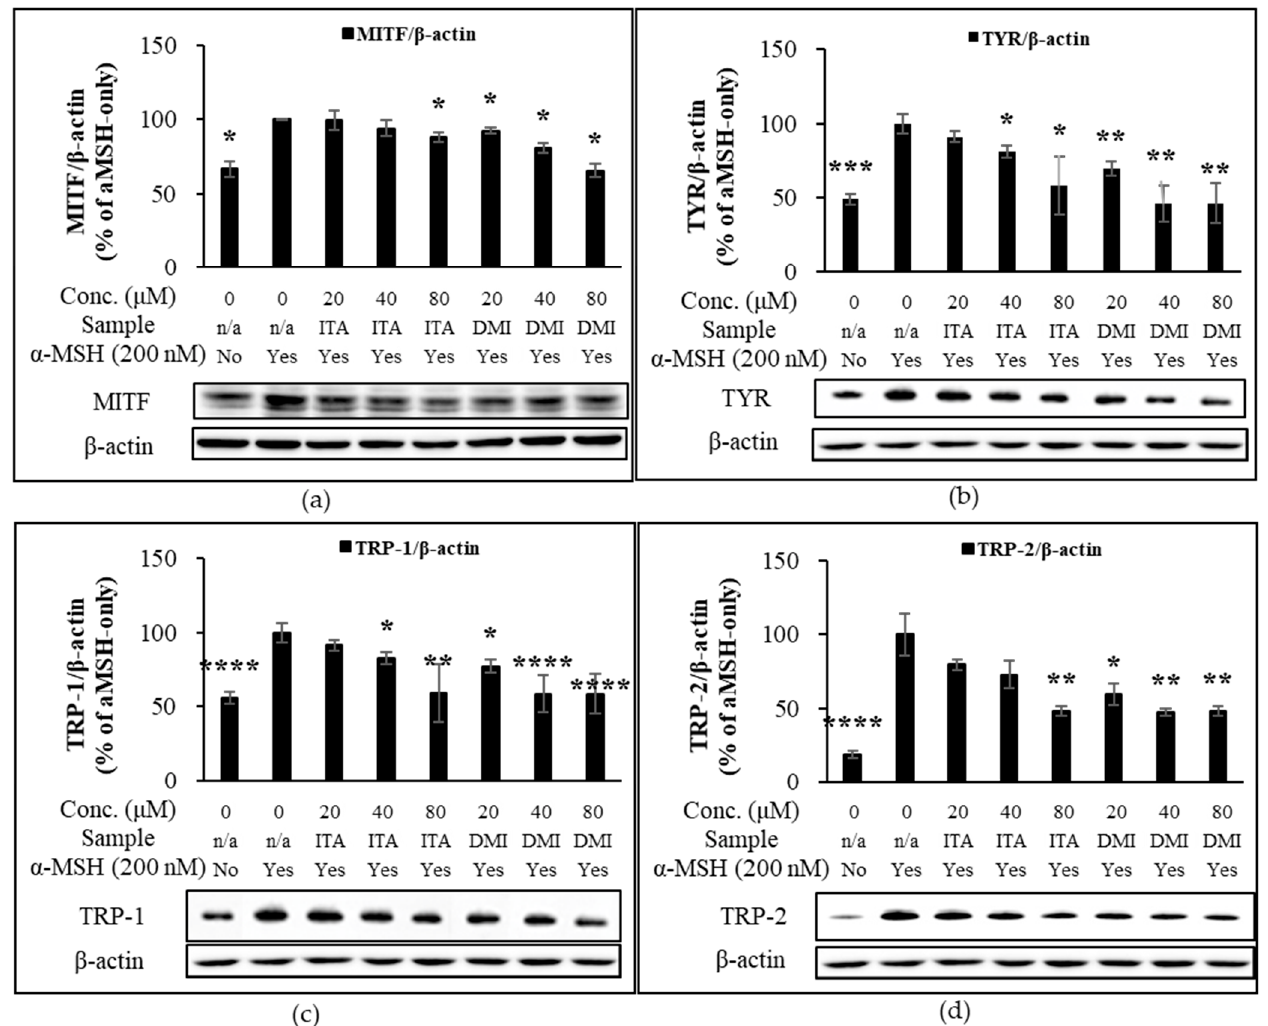
Figure 3. Effect of ITA and DMI on the α -MSH-induced expression of melanogenesis proteins. The expression level of melanogenic proteins was normalized to that of β -actin and compared to that of α -MSH only. ( a ) MITF/ β -actin. ( b ) TYR/ β -actin. ( c ) TRP-1/ β -actin. ( d ) TRP-2/ β -actin. The data were presented as the mean ± standard deviation of three independent experiments; * p < 0.05, ** p < 0.01, *** p < 0.005, **** p < 0.001 compared with α -MSH only.